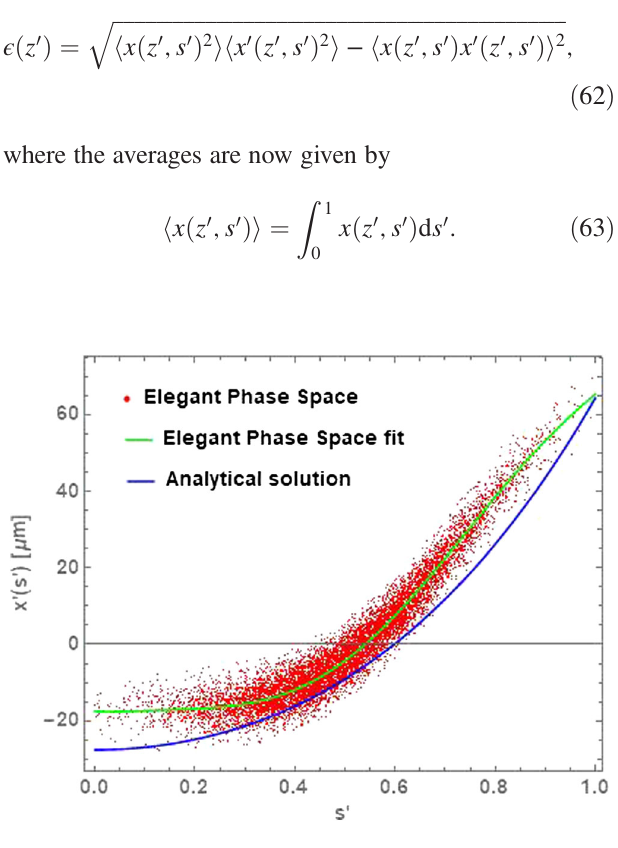
FIG. 46. Comparison of x 0 ð z 0 ¼ 1 ; s 0 Þ between the ELEGANT tracking code results and the analytical formulation for a bunch which has traveled through the 24 rf structures of XARA. Shown in red is the raw phase space of the bunch, a fit of which is given in solid green. The analytical result is shown in blue.